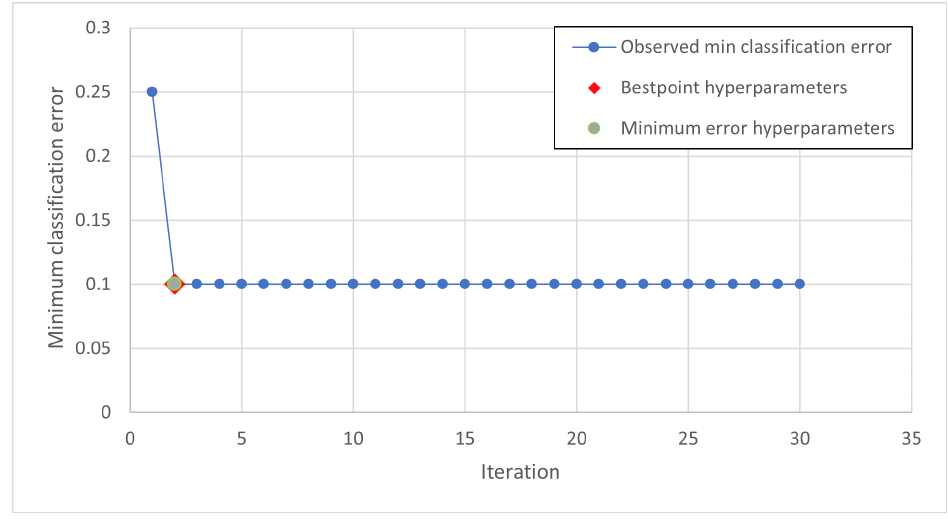
Figure 9. Neural network minimum classification error.